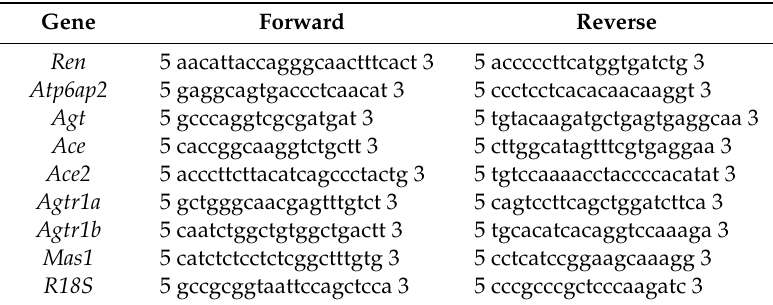
Table 3. PCR primer